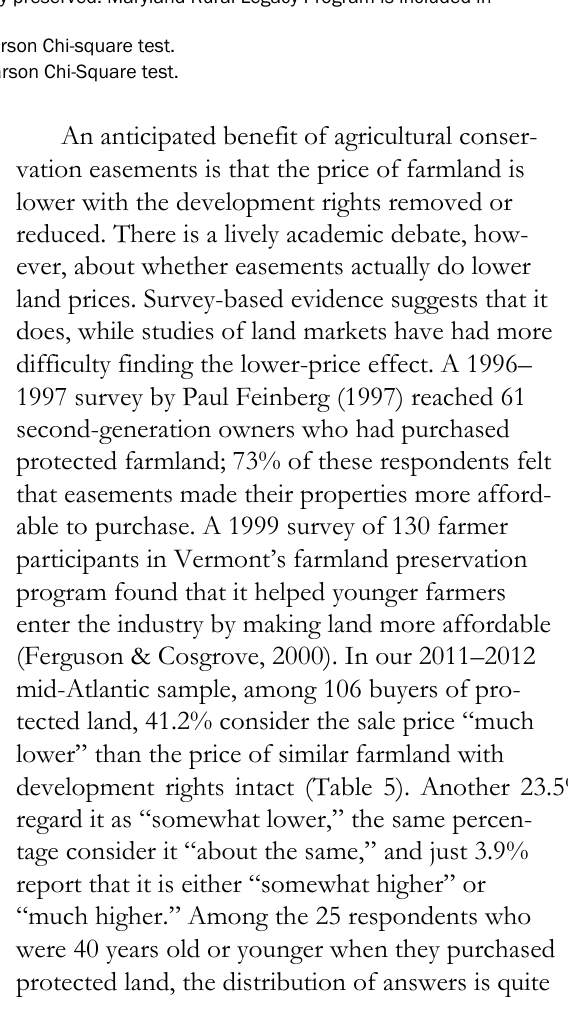
% of Owner-operators ≤ 35 Years